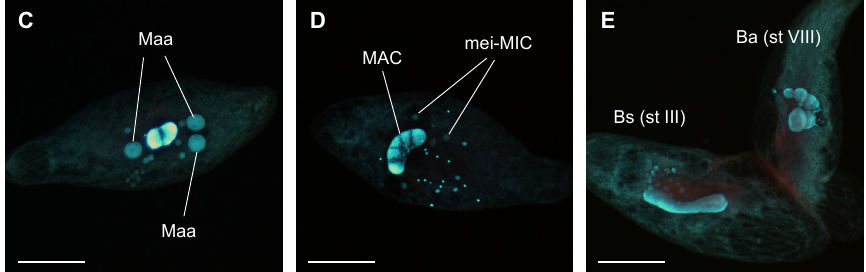
Figure 5. Frequency of abnormal nuclear changes of micronuclei in intra-species ( B. americanum – B. americanum ) and inter-species ( B. americanum – B. stoltei ) pairs. % of abnormal nuclear changes in the intra-species ( A ) and in the inter-species ( B ). An exconjugant with an abnormal number of anlagen ( C ), prematurely separated mating cell ( D ), and mating cells with an asynchronous progression of nuclear changes ( E ). Maa: macronuclear anlagen; mei-MIC: meiotic micronuclei; MAC: macronucleus; Ba (st VIII): B. americanum (stage VIII, metaphase of Meiosis I); Bs (st III): B. stoltei (stage III, early prophase of Meiosis I). Scale: 50 µm.